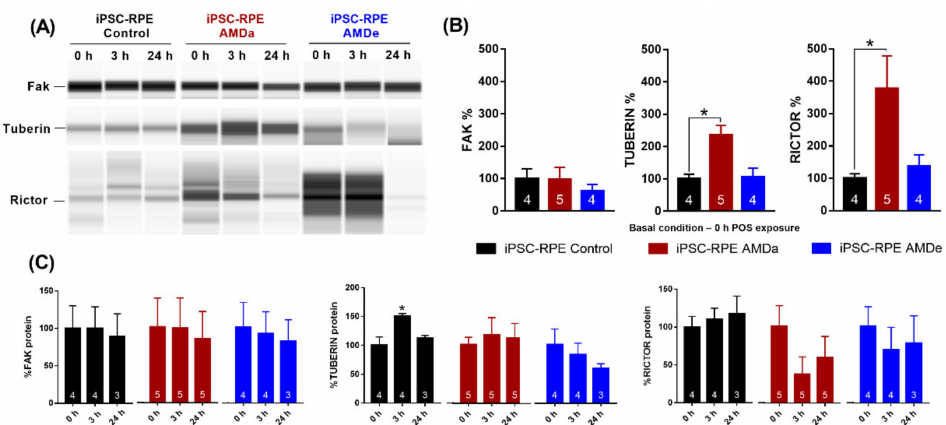
Figure 6. Analysis of expression levels and activity of proteins after POS exposure. Western blot analysis of fak, rictor and tuberin ( A ) and Western blot quantification ( B , C ) on hiPSC-RPE Control (N = 4), AMDa (N = 5) and AMDe cells (N = 4) (one analysis per cell line). Statistical analysis: one-way ANOVA and post hoc Turkey’s multiple comparison. Comparison of each dose between hiPSC-RPE Control and AMD cells ( B ) or for each cell line between 0 and 3 h/24 h ( C ); * p <